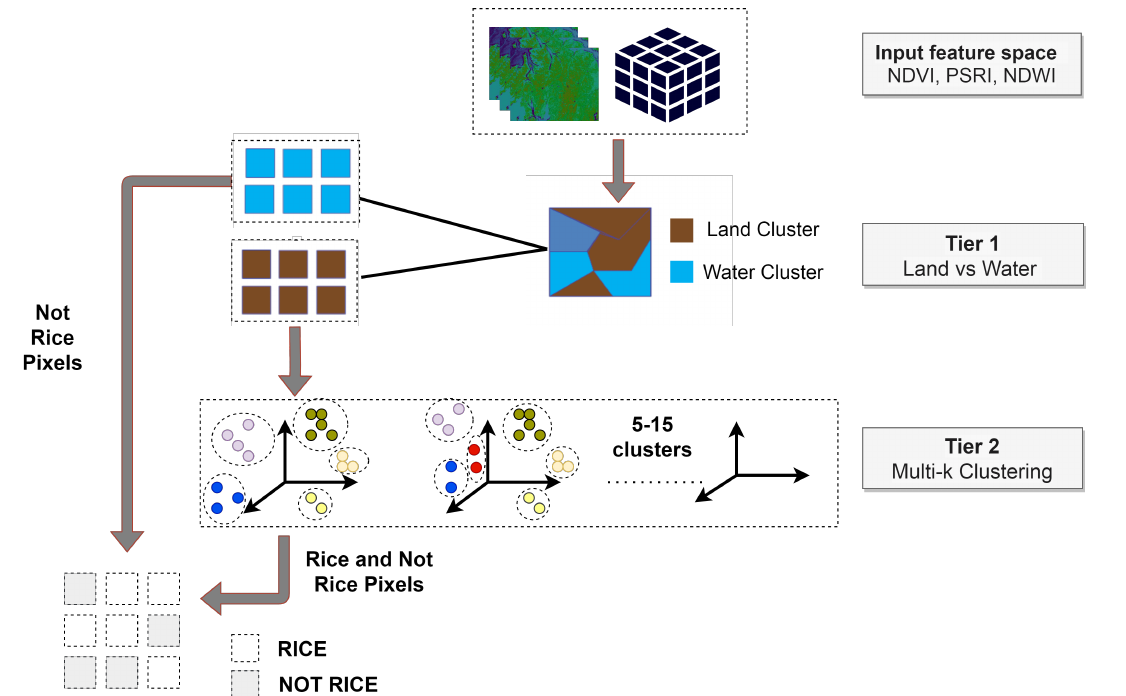
Figure 9. Workflow for generating rice pseudo-labels using k-means